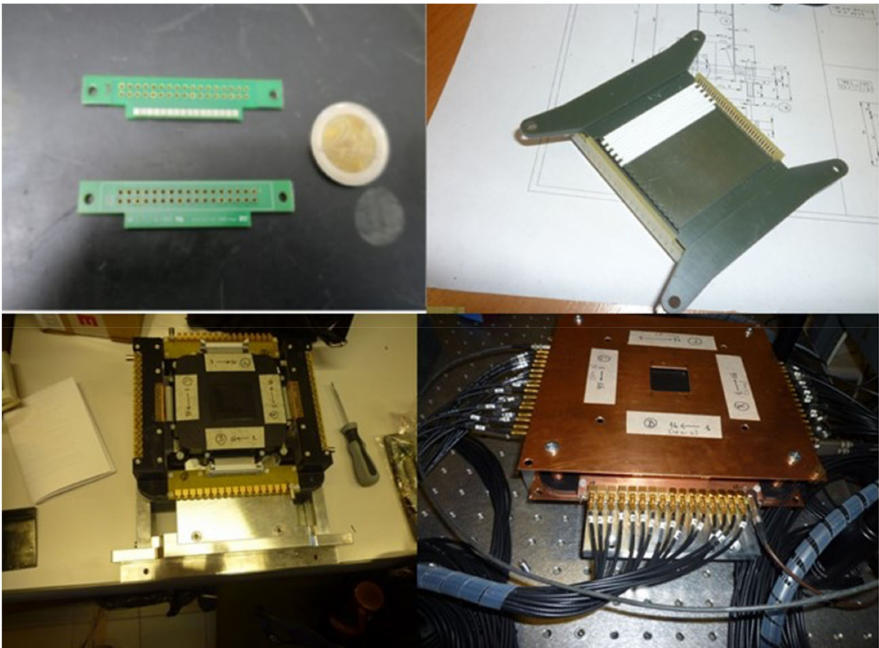
Figure 6. Top left panel: Picture of the PCBs with 1 mm SiPM soldered on. Top right panel: Picture of one fiber holder with some 1 mm fibers inside. The two PCBs with SiPM are shown. Bottom left panel: Mechanics layout of the 1 mm beam hodoscope. Bottom right panel: Image of the mounted detector. Signal/power cables are fanned out through the feedthrough along the lateral side of the structure.